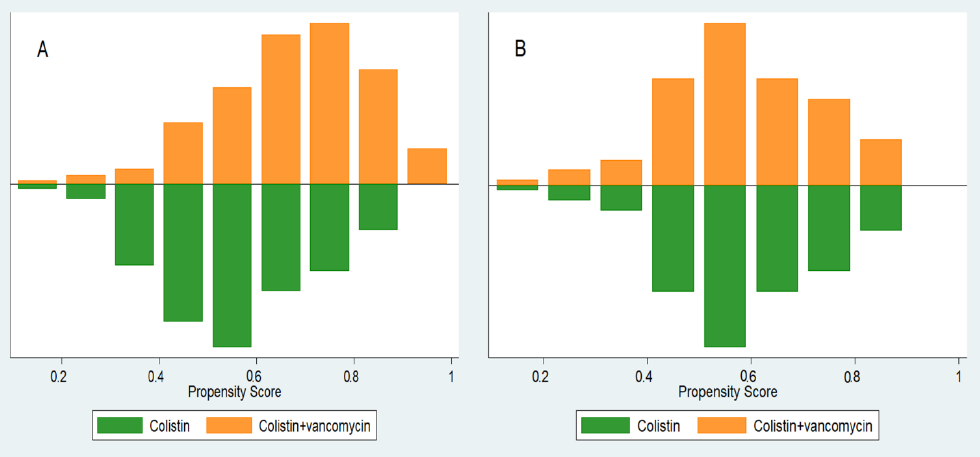
propensity scores between groups before and after matching. The characteristics of the patients between the two groups were largely comparable after propensity matching (Table 1).